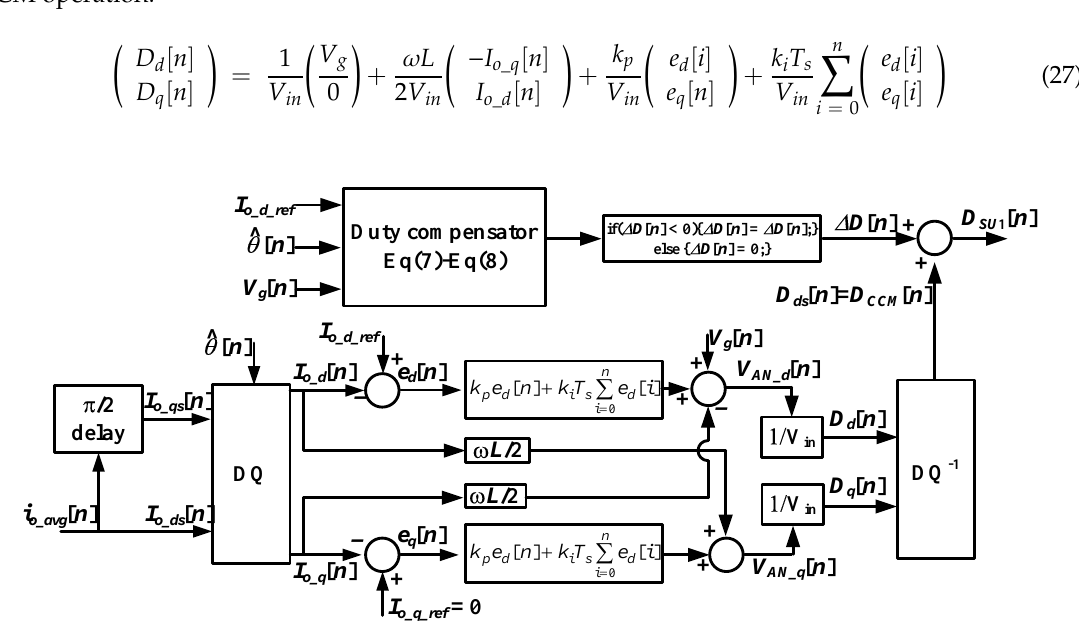
Figure 7. Block diagram of the D-Q axis controller.